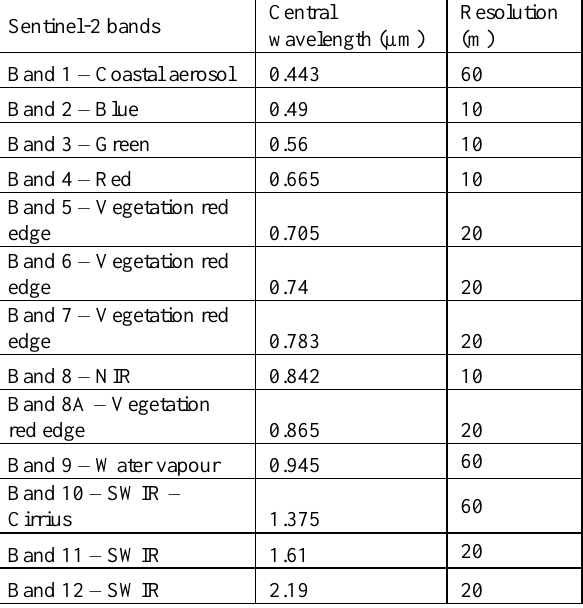
Table 1. Characteristics of Sentinel 2 Strips